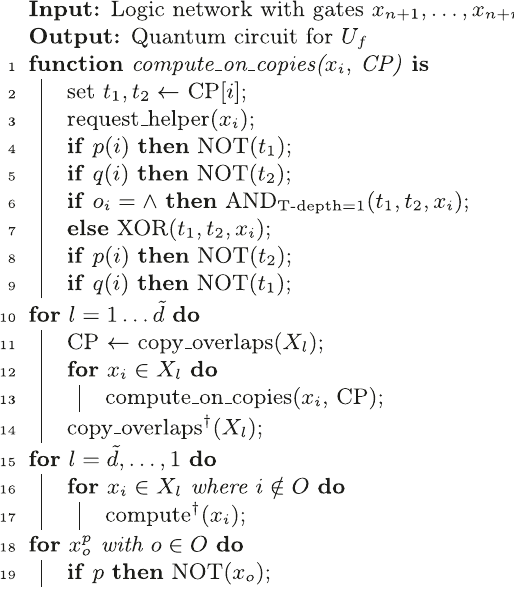
Algorithm 2 . Low T-depth compilation algorithm.